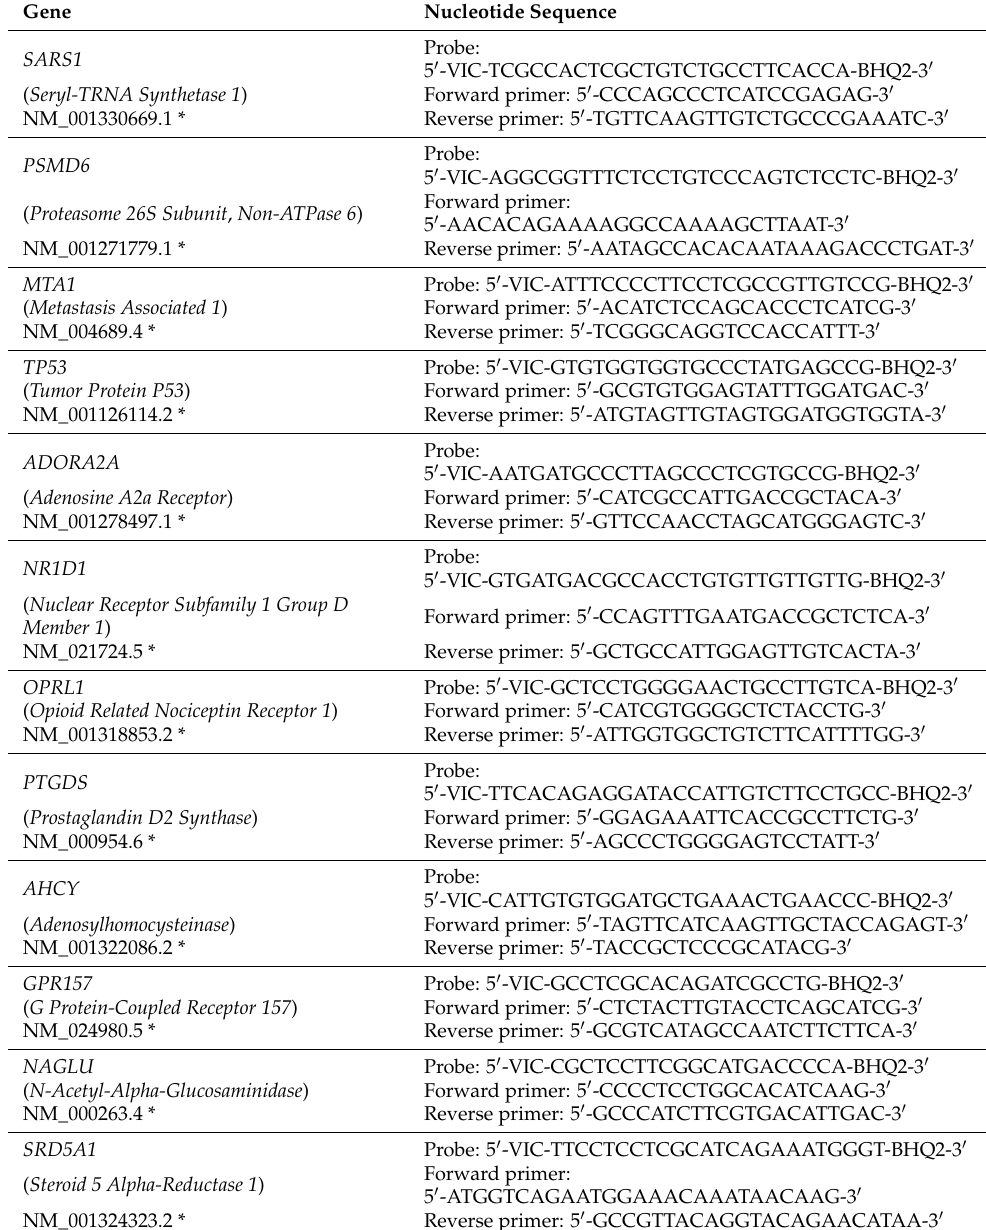
Table 2. Sequences of gene-specific primers and